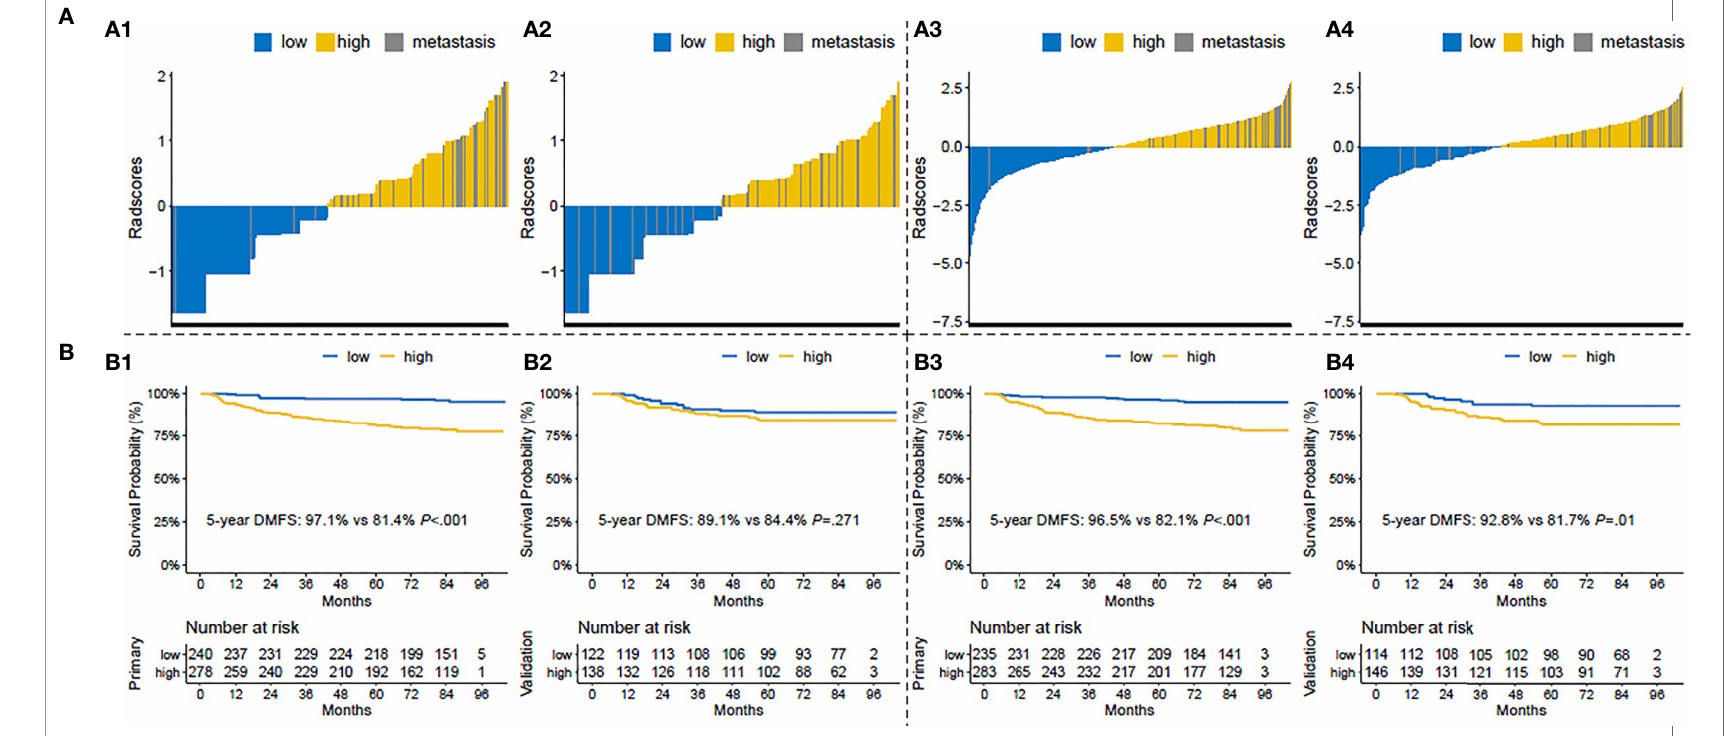
FIGURE 2 | (A) Risk score distributions: (A1) in the primary cohort of the clinical prognostic model, (A2) in the validation cohort of the clinical prognostic model, (A3) in the primary cohort of the T1+T1C prognostic model, A4) in the validation cohort of the T1+T1C prognostic model. (B) Kaplan – Meier survival curves of distant metastasis-free survival (DMFS) in patients of the low- and high-risk groups: (B1) in the primary cohort of the clinical prognostic model, (B2) in the validation cohort of the clinical prognostic model, (B3) in the primary cohort of the T1+T1C prognostic model, (B4) in the validation cohort of the T1+T1C prognostic